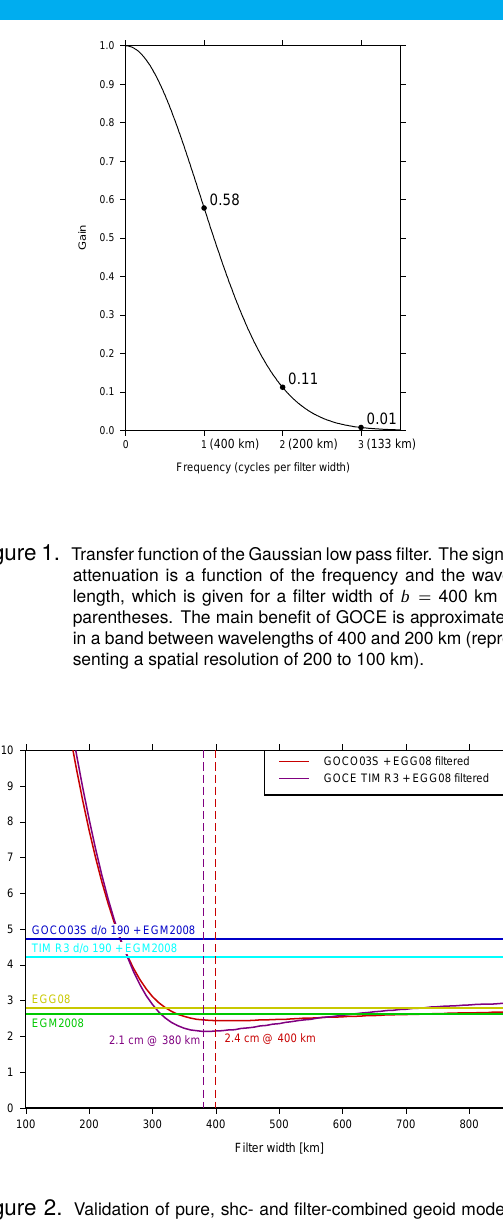
Figure 2. Validation of pure, shc- and filter-combined geoid models versus observed height anomalies at 954 GNSS/leveling points in